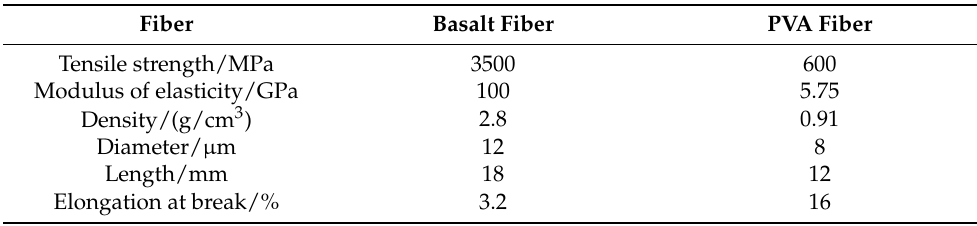
Table 1. Physical and mechanical properties of basalt fiber and PVA fiber.